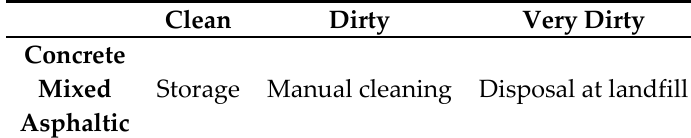
Table 1. Classification of the CDW at the entrance and